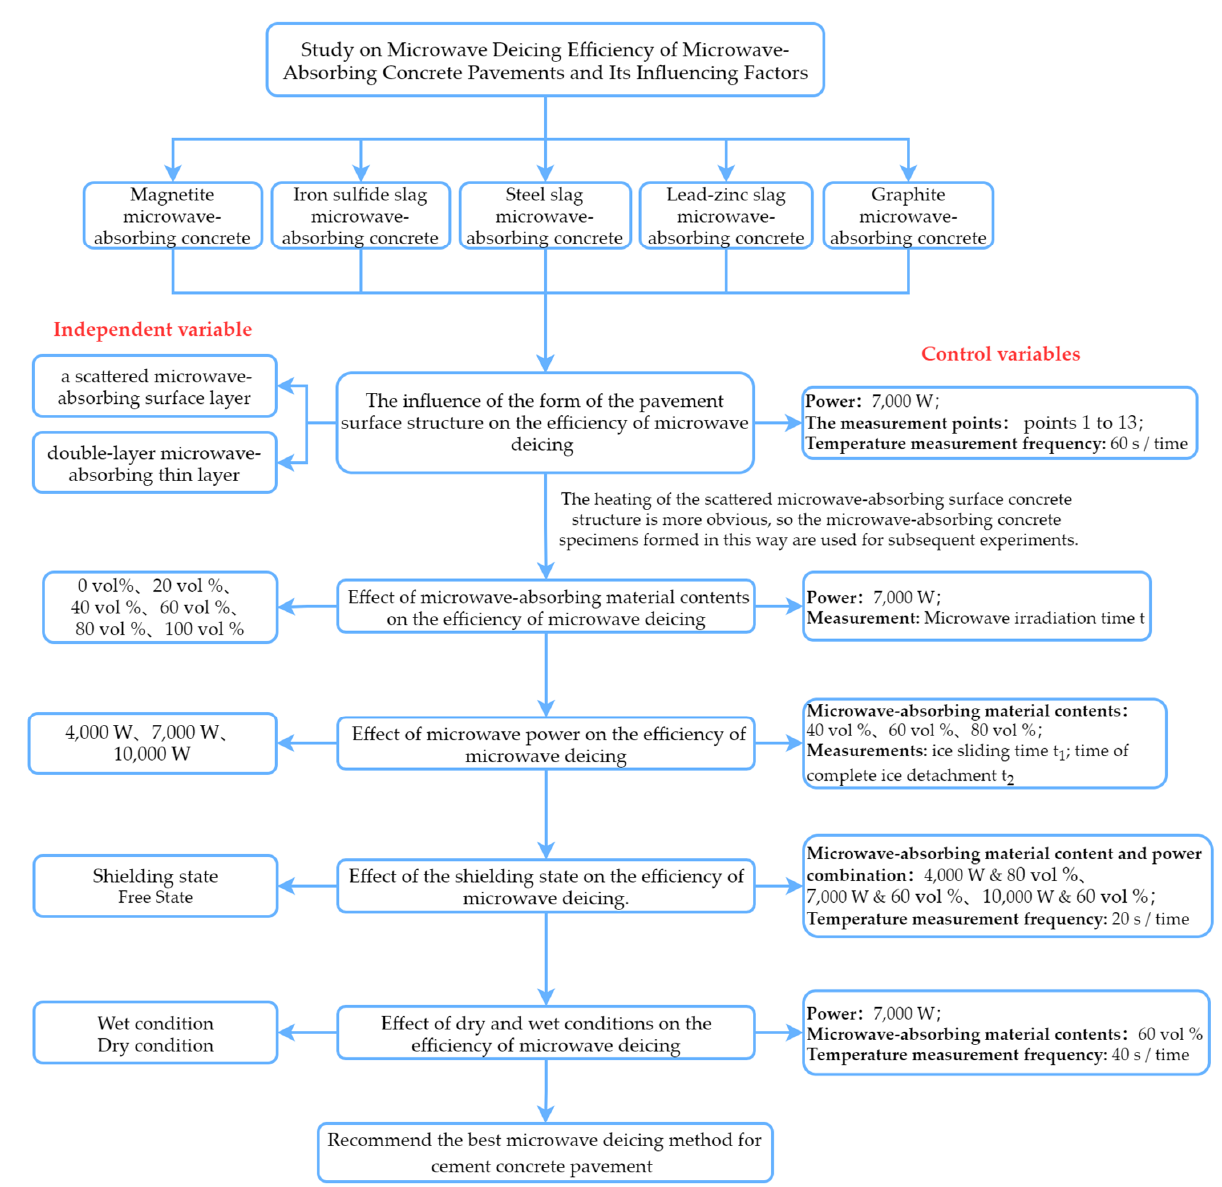
Figure 5. Experimental flow chart of microwave deicing efficiency and influencing factors of microwave-absorbing concrete road surface research.